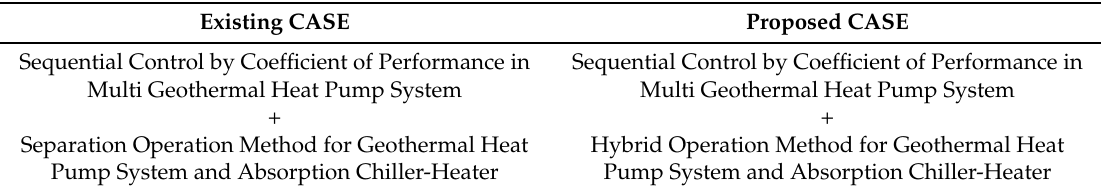
Table 7. Simulation CASE.